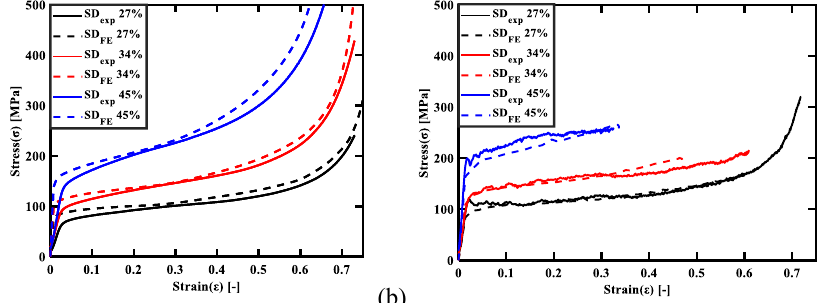
Fig. 8. Strain-stress responses of SD TPMS (a) quasi-static and (b) dynamic loaded.